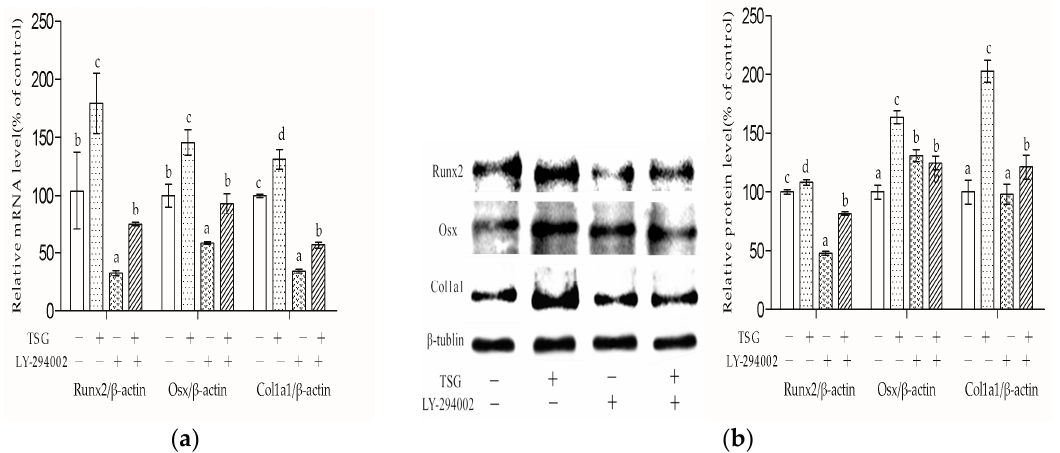
Figure 8. Effect of TSG and LY-294002 on Runx2, Osx, and Col1a1. ( a ) mRNA and ( b ) Protein levels of the MC3T3-E1 cells. Data are represented as the mean ± SD of three determinations. Different letters indicate significant differences ( p < 0.05).